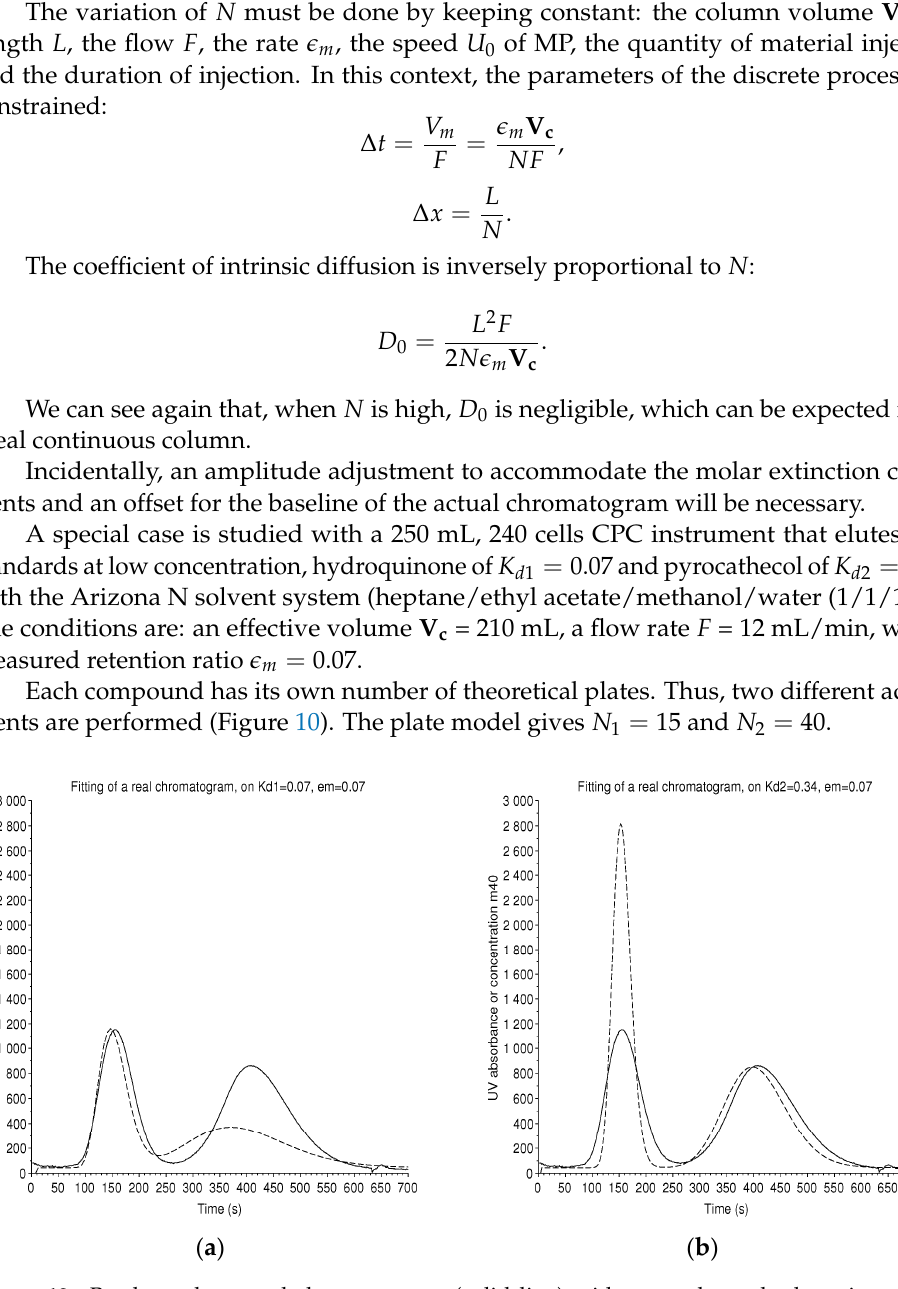
Figure 10. Batch mode: a real chromatogram (solid line) with two solutes, hydroquinone and pyrocatechol in Arizona N solvent system, from a 250 mL, 240 cells CPC instrument, at a flow rate of 12 mL/min. The number of plates is not uniform from peak to peak. A simulated chromatogram (dashed line) is made to coincide on the peak of hydroquinone at K d 1 = 0.07 ( a ) and on the peak of pyrocatechol at K d 2 = 0.34 ( b ). We find the theoretical number of plates N 1 = 15 and N 2 = 40 . For a low number of plates, even if the retention time is well computed, the maximum of the peak is slightly